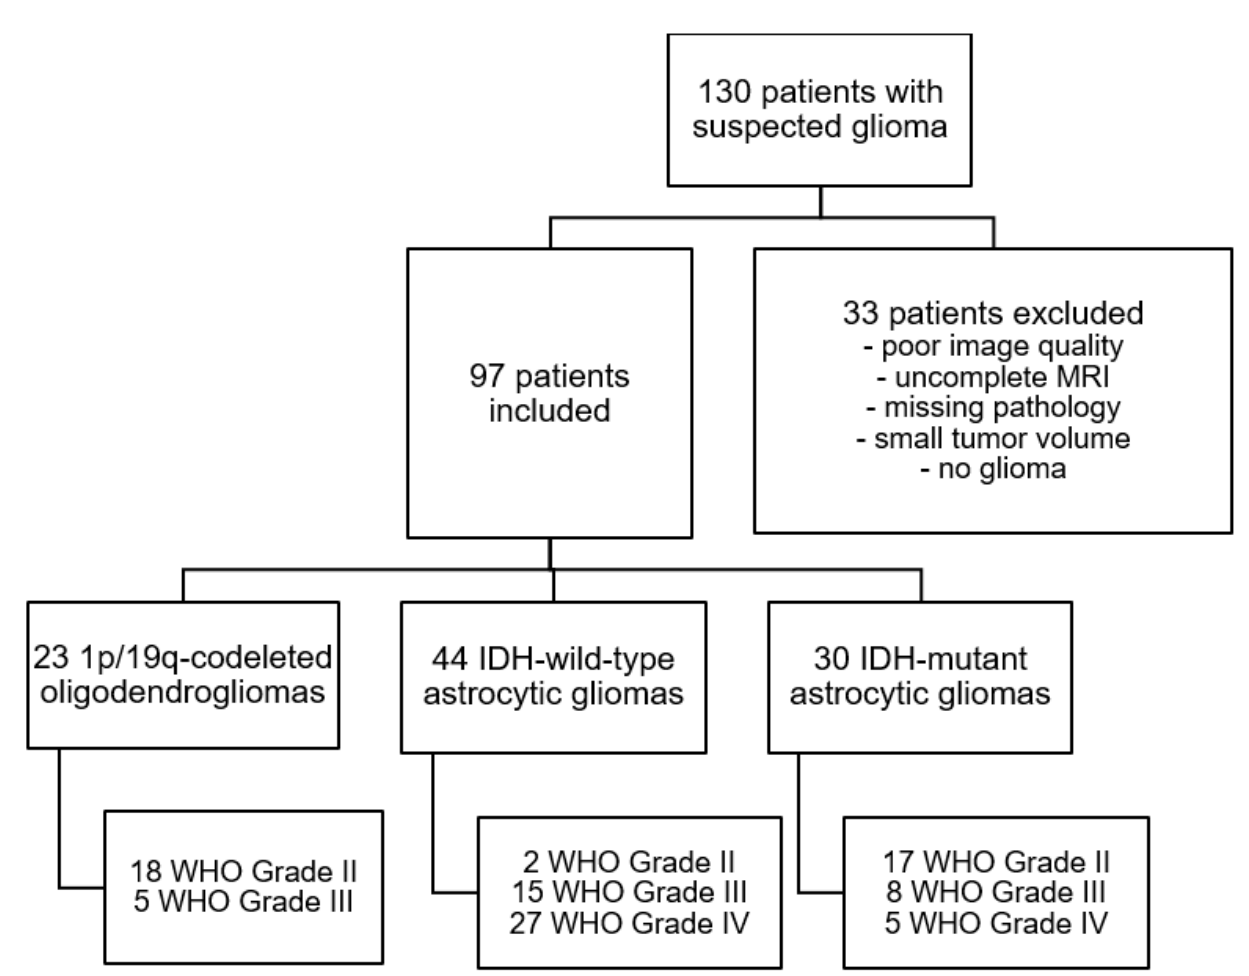
Figure 1. Patient selection algorithm according to the STROBE guidelines.